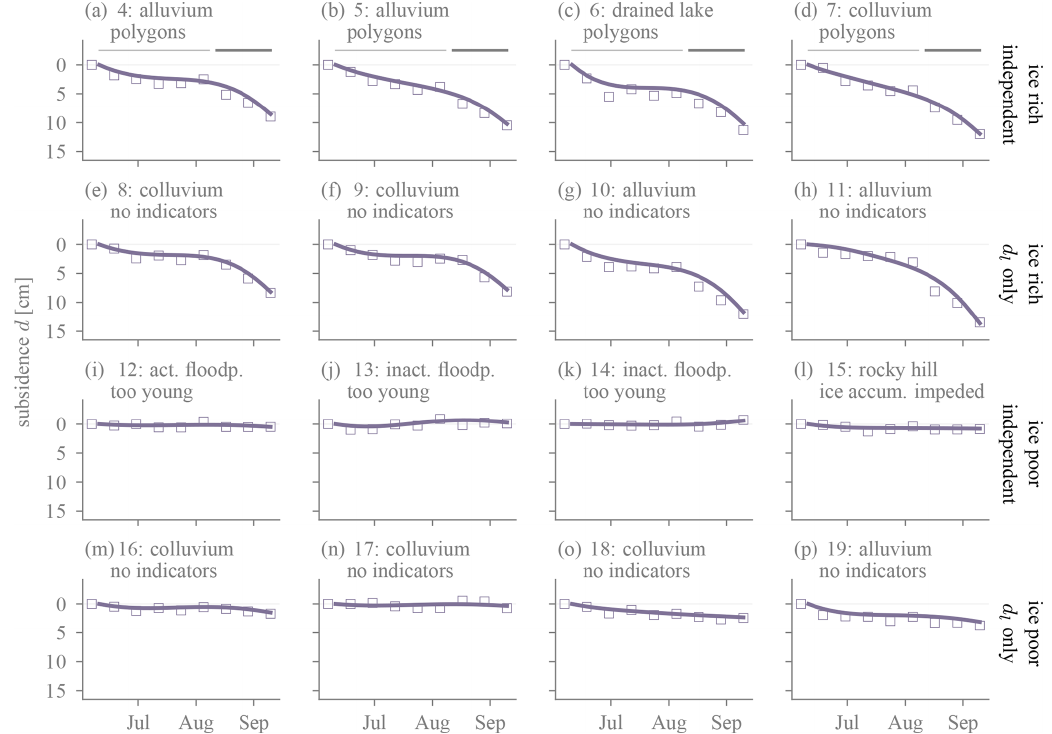
Figure 10. Subsidence time series (line: spline fit, markers: unconstrained) from 2019 for points shown in Figs. 7c and 5d. First row (a–d) : points that were independently determined to be ice rich; second row (e–h) indeterminate according to manual mapping, but d l > 2 . 5cm indicates they are ice rich; third row (i–l) : independently determined to be ice poor; fourth row (m–p) : indeterminate according to manual mapping, but d l indicates they are ice